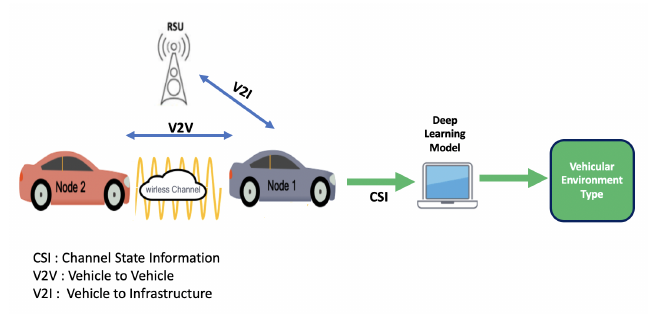
Figure 1. Vehicular environment identification